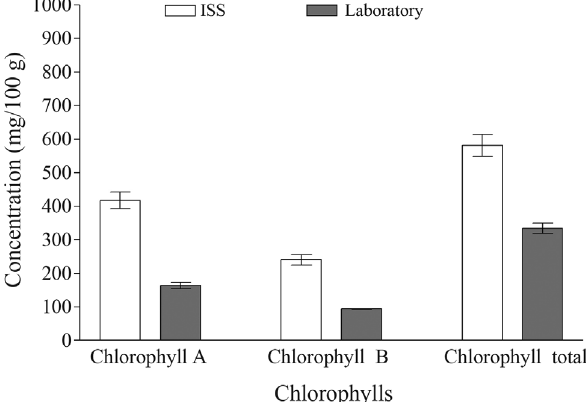
Figure 2 - Synthesis of chlorophylls in 30-day plantlets derived from seeds germinated in microgravity (ISS) and terrestrially (Laboratory). The chlorophyll content was measured relative to leaflet fresh weight, and dif- ferencesarestatisticallysignificant(p<0.001)accordingtoANOVAwith BonferronitestforallthreepairsofmeasurementsbetweentheISSandthe terrestrial laboratory. Error bars =